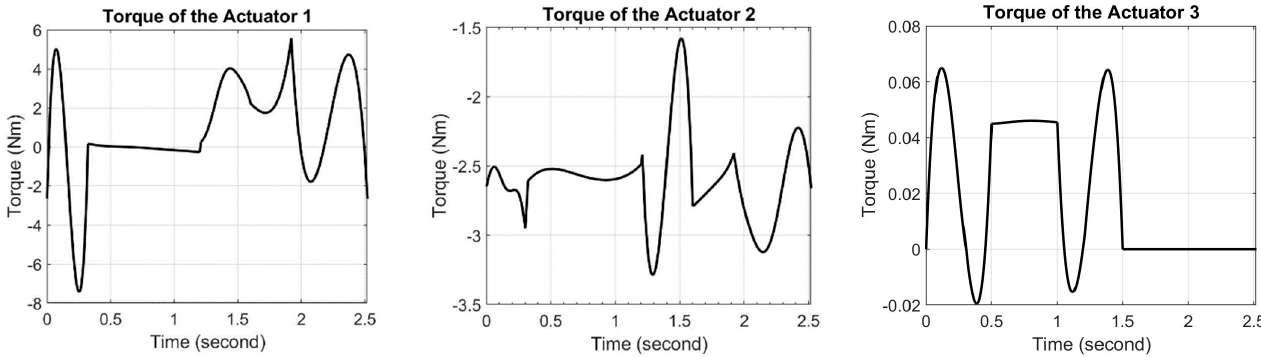
Figure 10. Joint torques for a gait cycle.